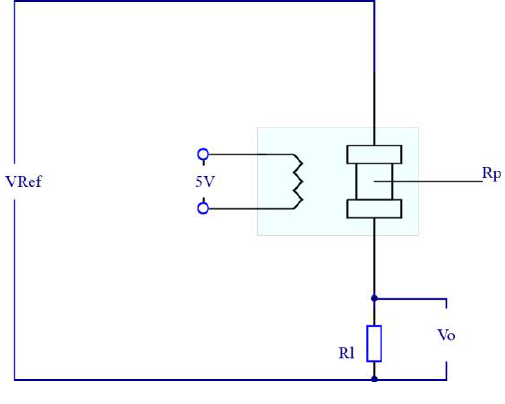
Figure 3. Drive circuit of the sensor.